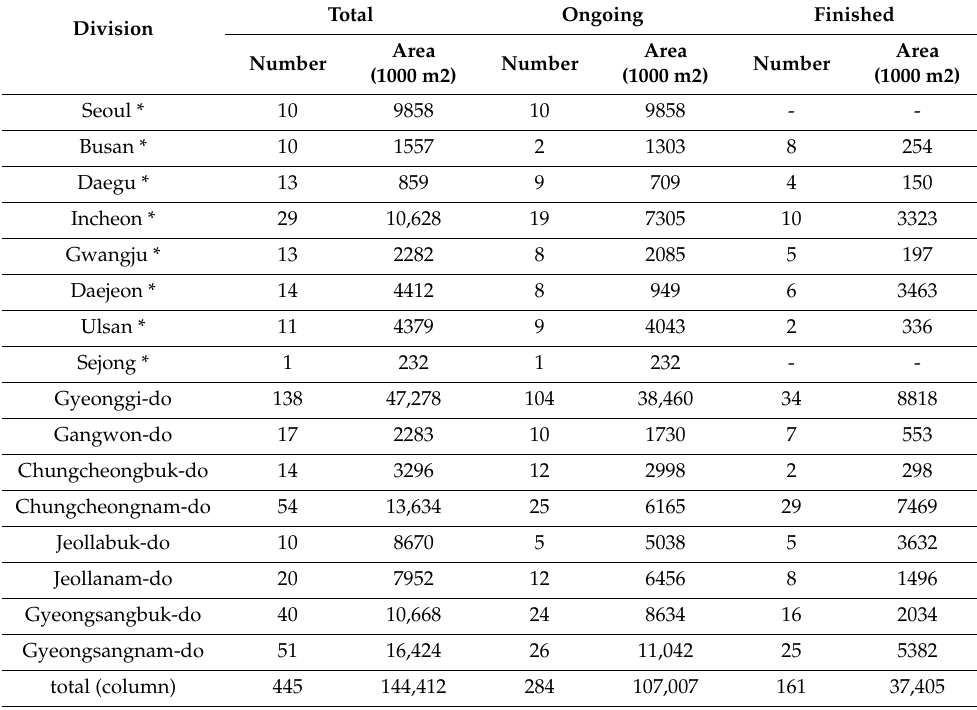
Table A1. Status of urban development projects in South Korea (2008–2017).